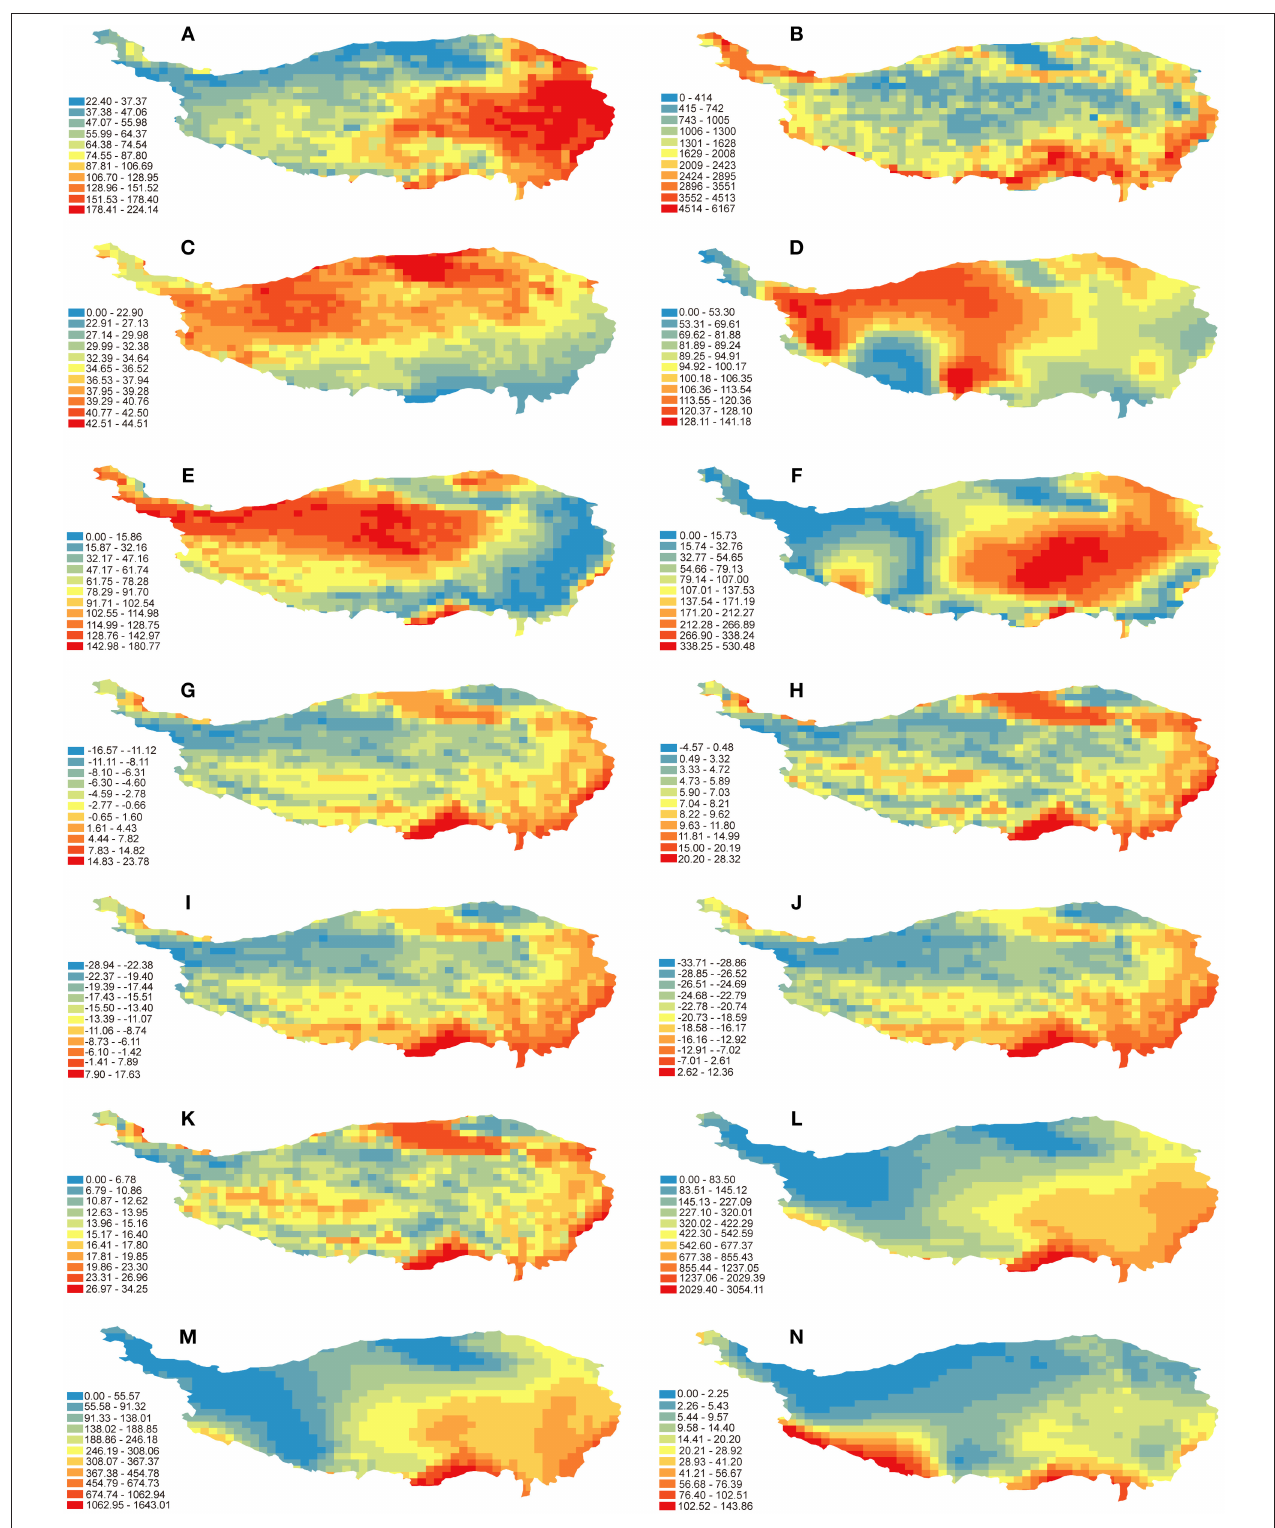
FIGURE 3 | Distribution patterns of environmental variables in the QTP. (A) NDVI, normalized difference vegetation index; (B) ELE, elevation range; (C) TAR, temperature annual range; (D) PS, precipitation seasonality; (E) Tano, MAT anomaly; (F) Pano, MAP anomaly; (G) MAT, mean annual temperature; (H) MTWAQ, mean temperature of warmest quarter; (I) MTCQ, mean temperature of coldest quarter; (J) MTCP, min temperature of coldest month; (K) MTWP, max temperature of warmest month; (L) MAP, mean annual precipitation; (M) PWAQ, precipitation of warmest quarter; (N) PCQ, precipitation of coldest quarter.